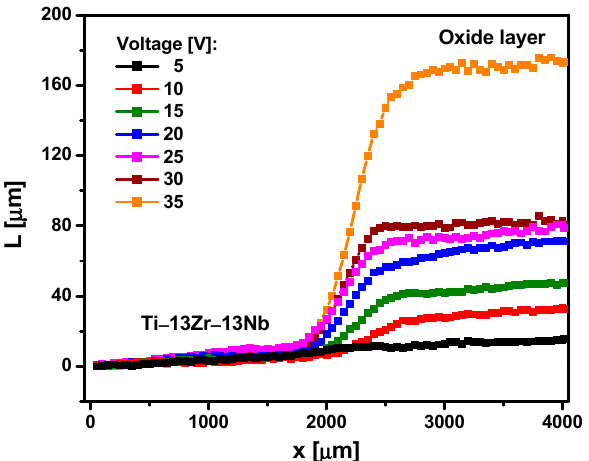
Figure 6. The thickness (L) of the oxide layer on the Ti-13Zr-13Nb alloy surface obtained by anodizing in 1 M C 2 H 6 O 2 + 4 wt% NH 4 F electrolyte at 5–35 V for 120 min, measured over distance x.